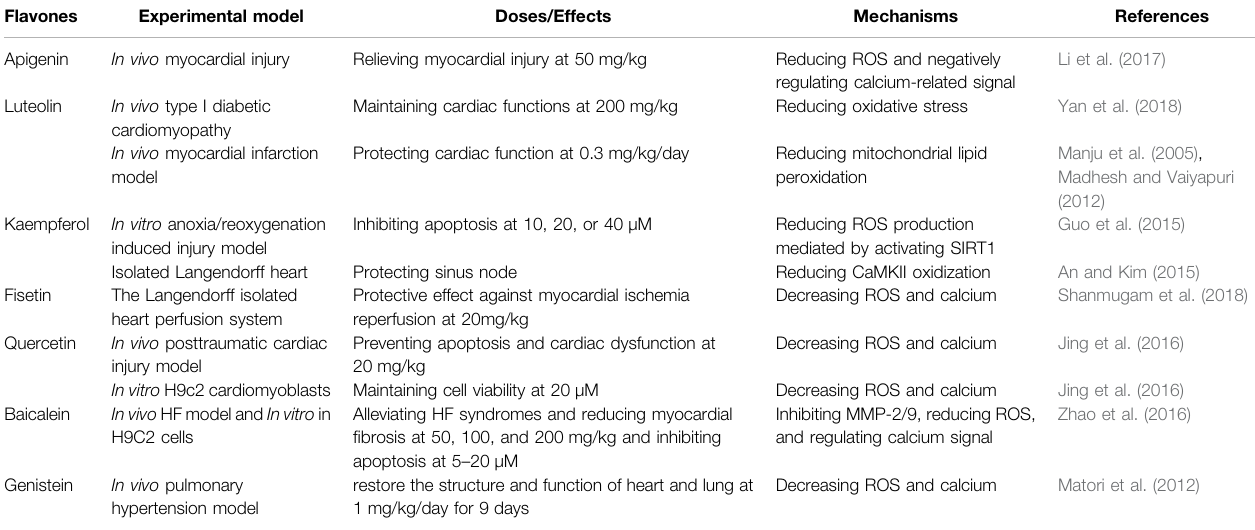
TABLE 1 | Summary of the discussed fl